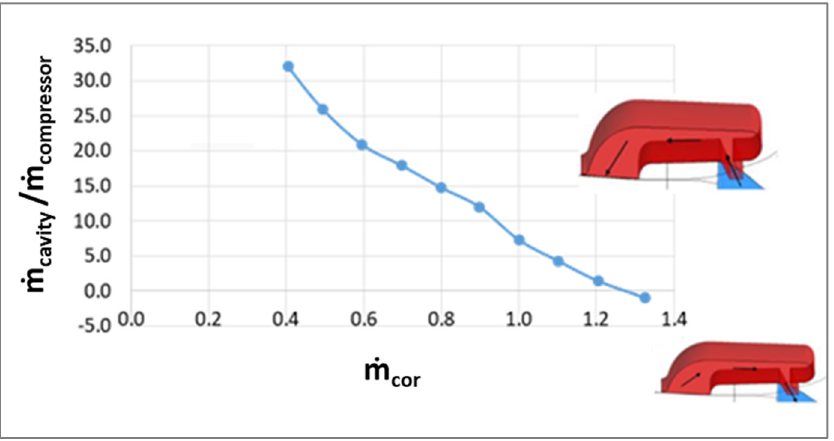
Figure 9. Distribution of the mass flow rate passing in the cavity, by varying the operating condition, at N cor = 1.0.